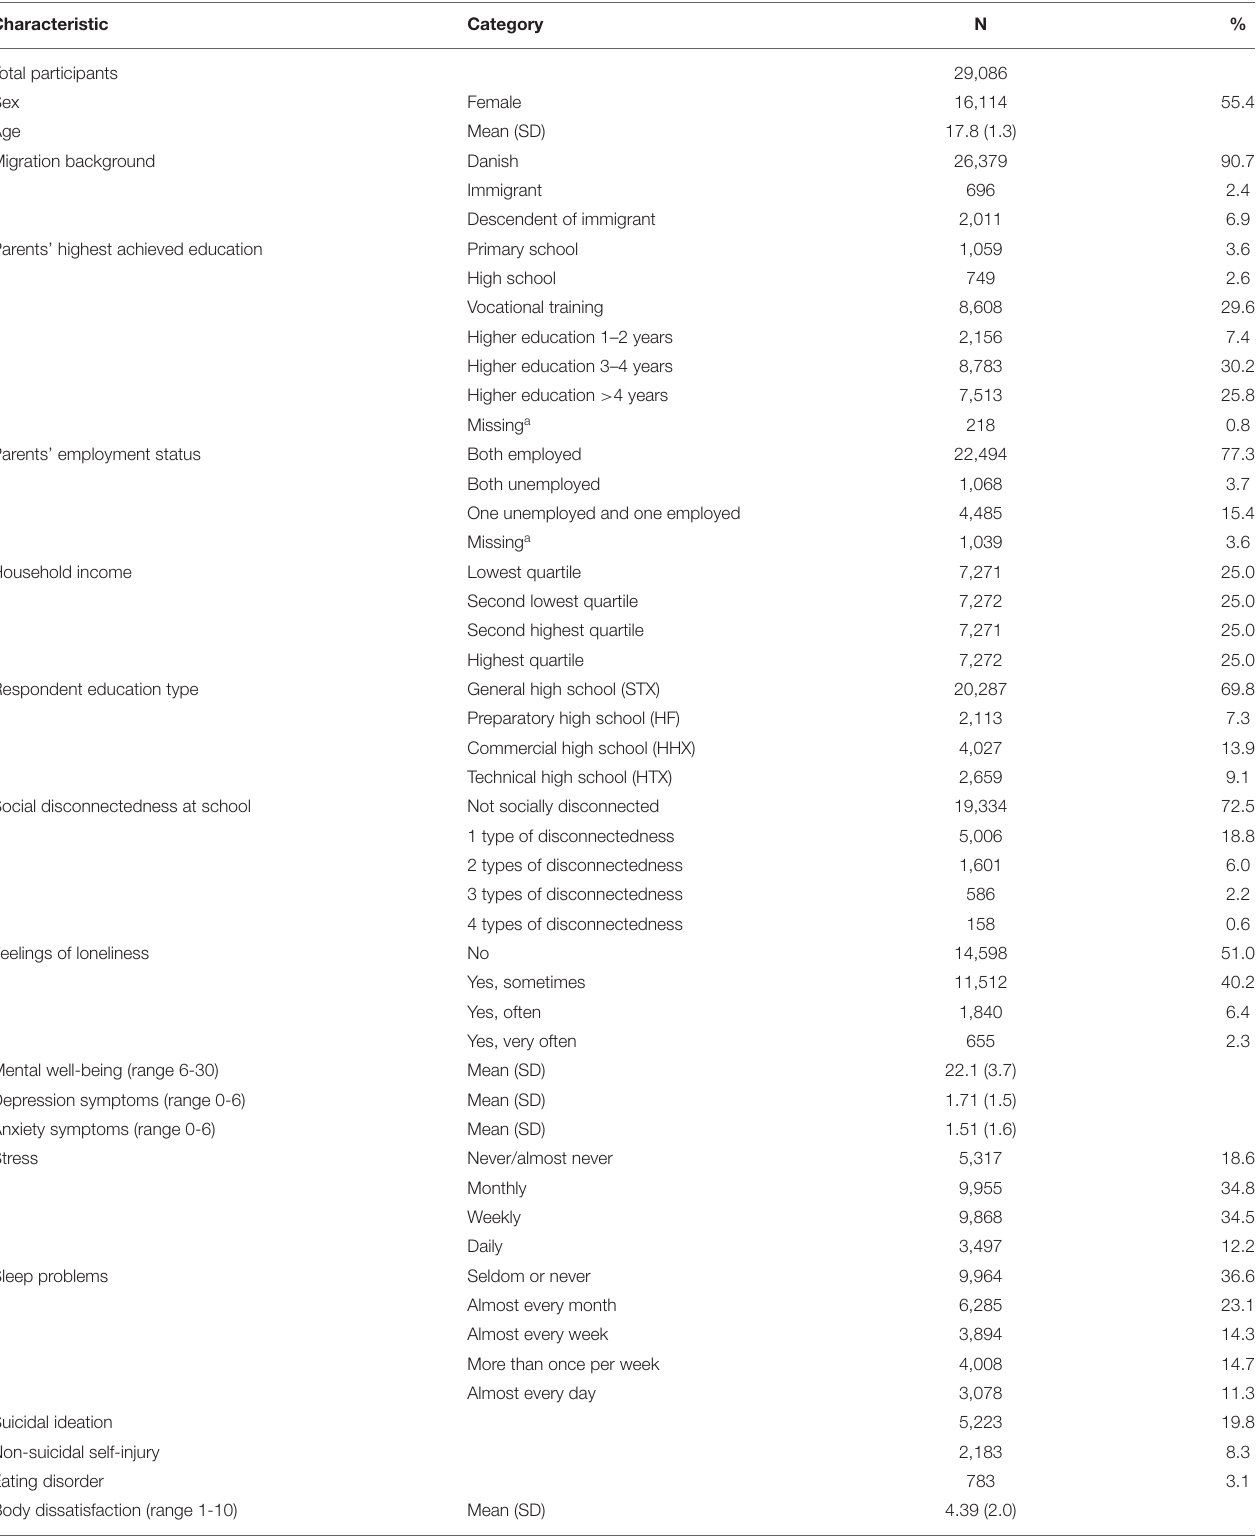
TABLE 1 | Characteristics of the study